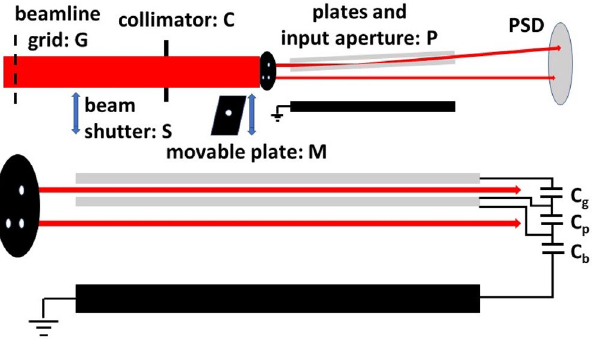
Figure 1. Upper portion: Overall schematic of the guiding assembly. Showing the guided and bypass beams in a tilted plate configuration. Lower portion: an expanded view showing the plate assembly aligned with the beam axis. The length is not to scale and the three capacitors illustrate the equivalent electric circuit model used and are NOT part of the experimental setup.